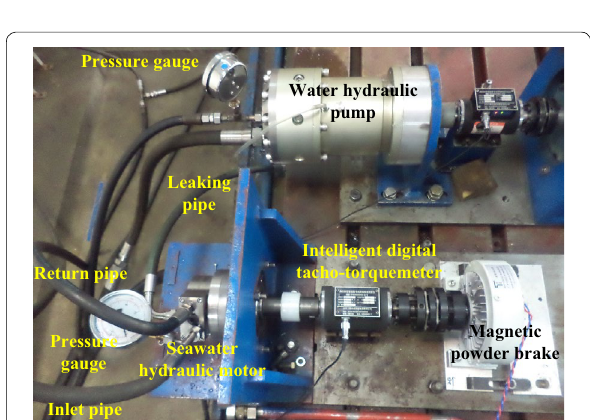
Figure 19 Test system of seawater hydraulic motor